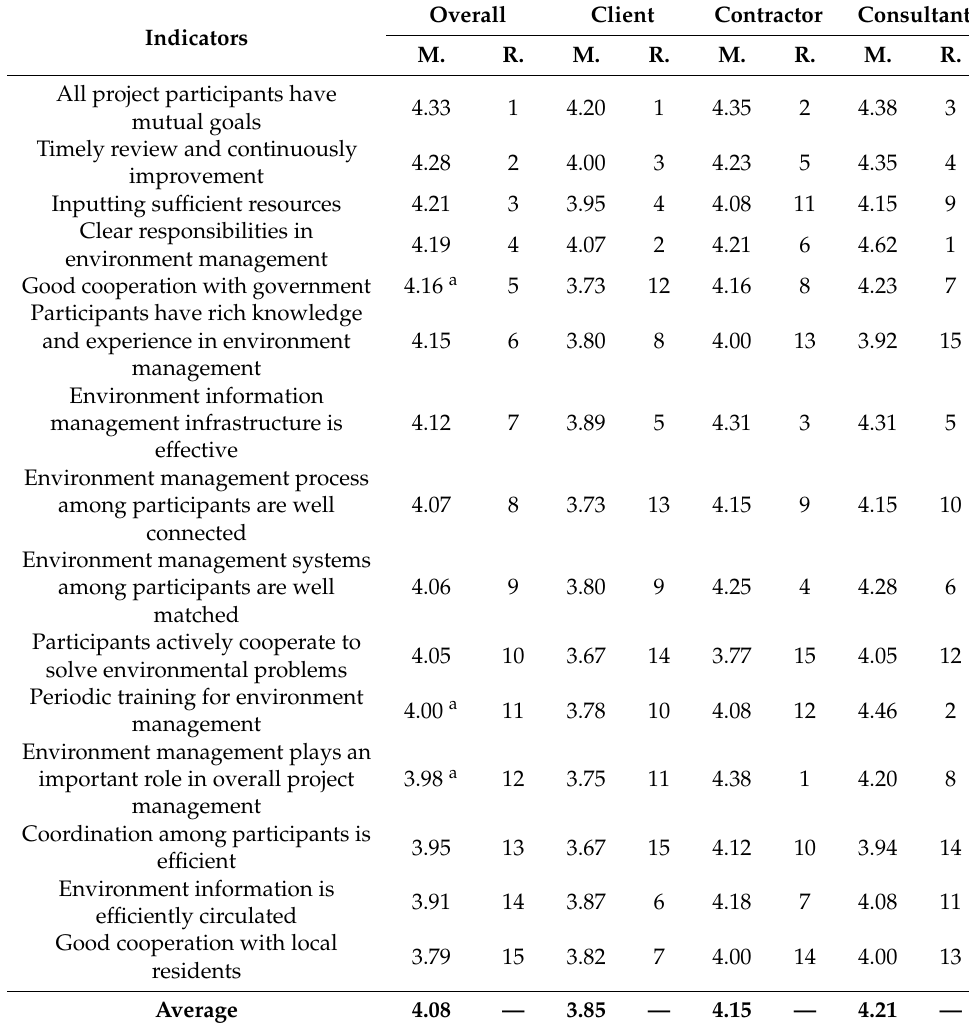
Table 3. Cooperative environment